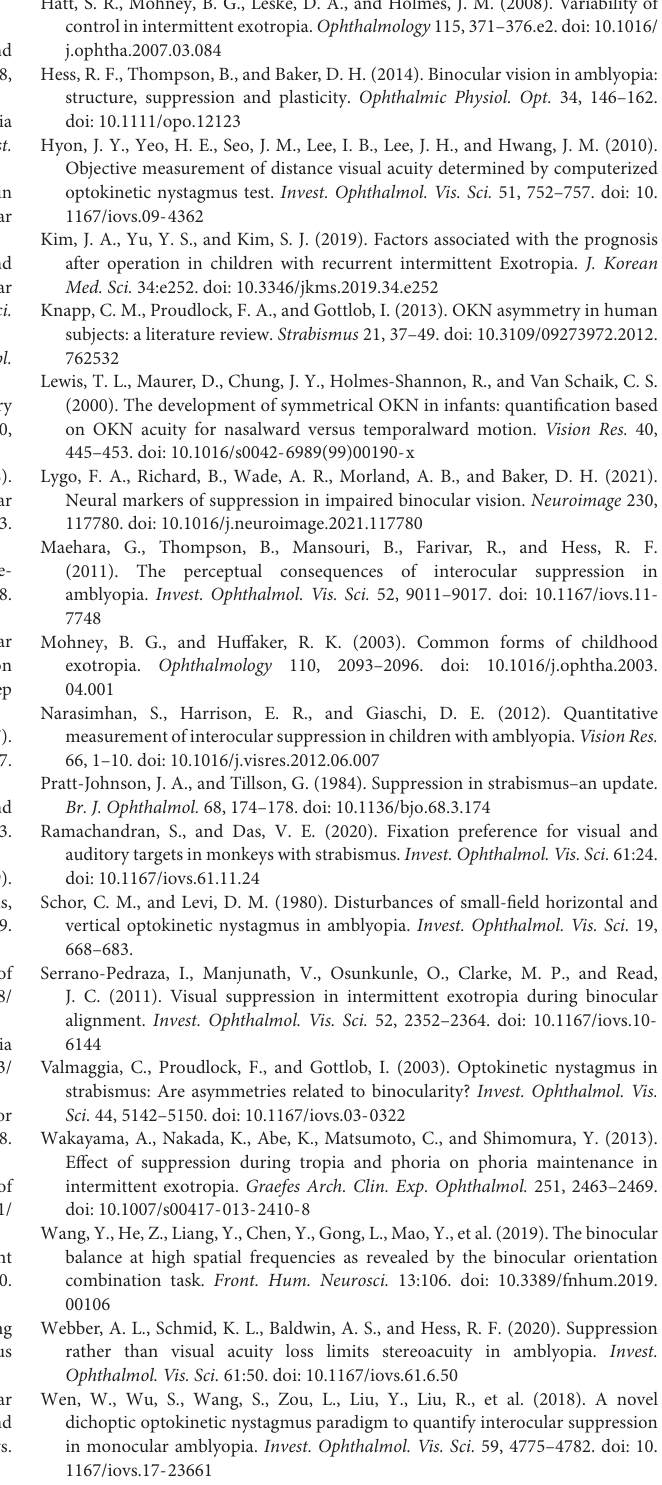
was fixed at 100%, while it varied for the dominant